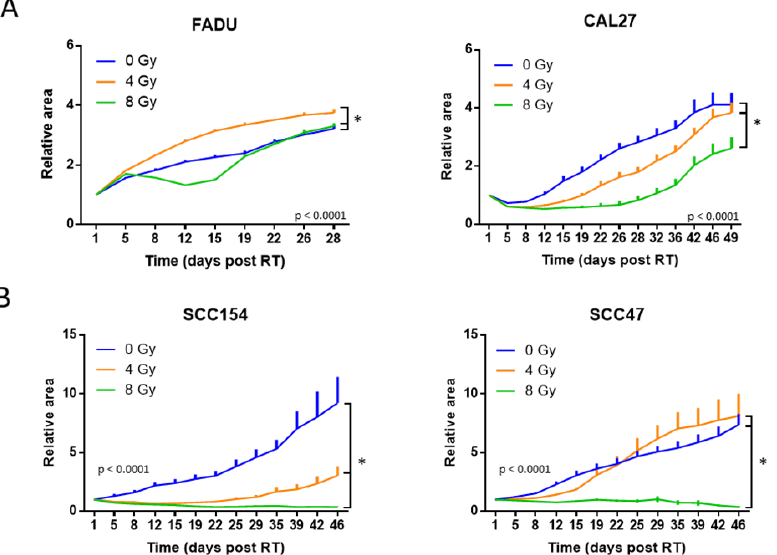
Figure 2. RT response in 3D spheroids of HPV-negative and HPV-positive cells assessed by tumor growth curves. ( A ) Relative tumor growth curves of HPV-negative FADU and CAL27 spheroids. The spheroids were treated with 4 Gy and 8 Gy at day 7 after seeding. ( B ) Relative tumor growth curves of HPV-positive SCC154 and SCC47 spheroids. The spheroids were treated with 4 Gy and 8 Gy at day 14 after seeding. ( A , B ) Relative curves were normalized to the spheroid area at the start of RT treatment. Day 1 indicates the start of treatment. Data are presented as mean ± s.e.m., n = 3 . p -values < 0.05 were determined by two-way ANOVA.